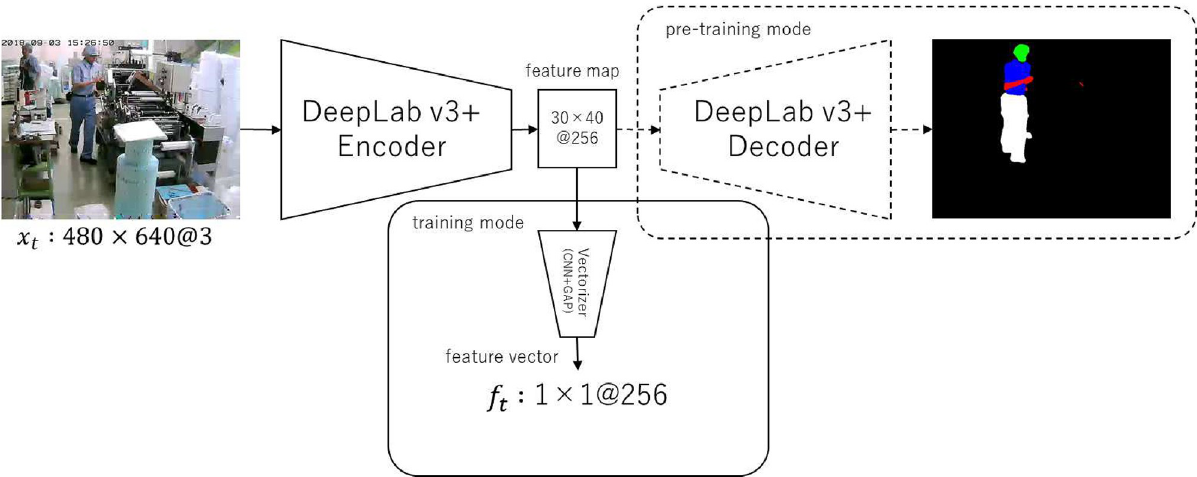
Fig 5. Our segmentation heuristics factory pre-training